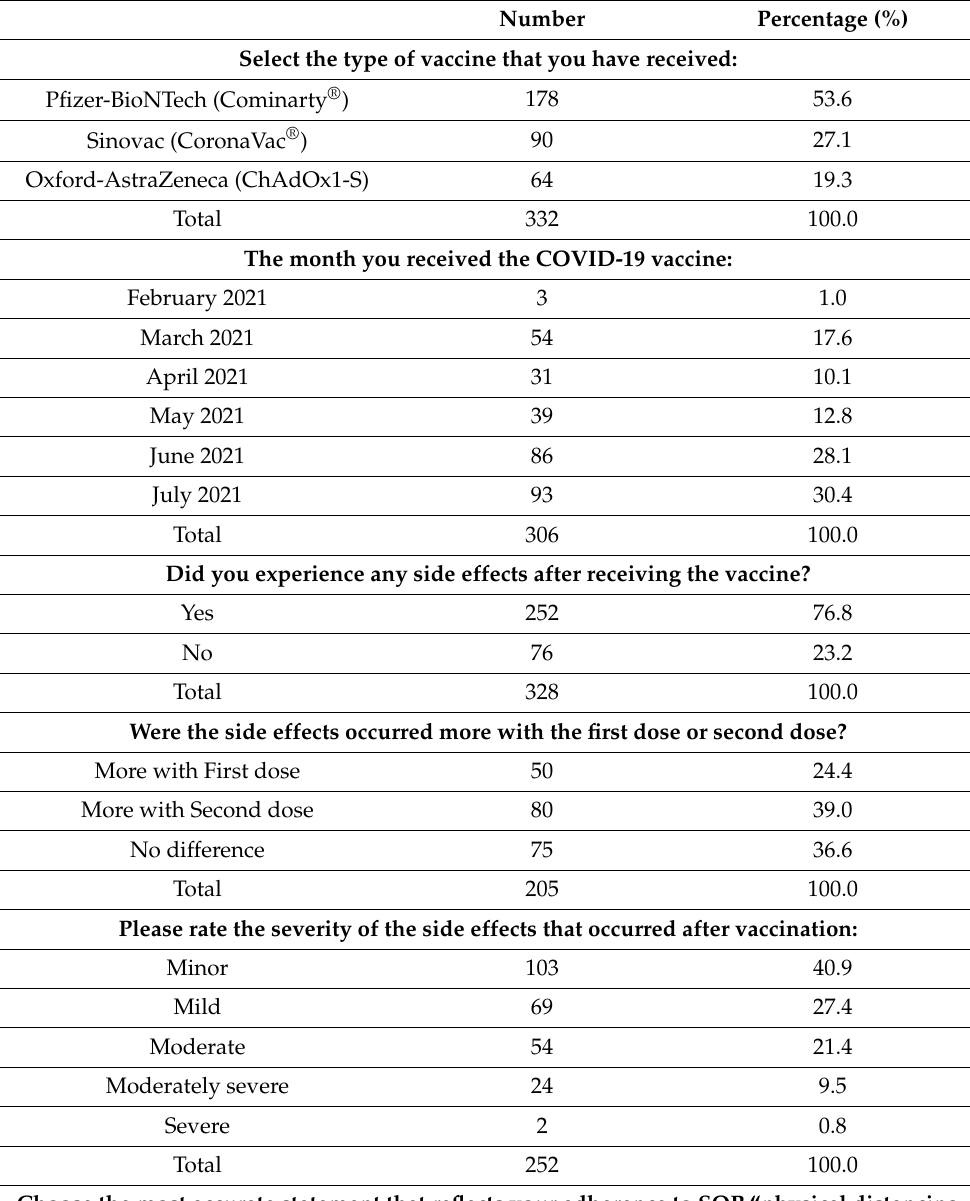
Table 3. Information on vaccine types, side effects, and sources of vaccine-related